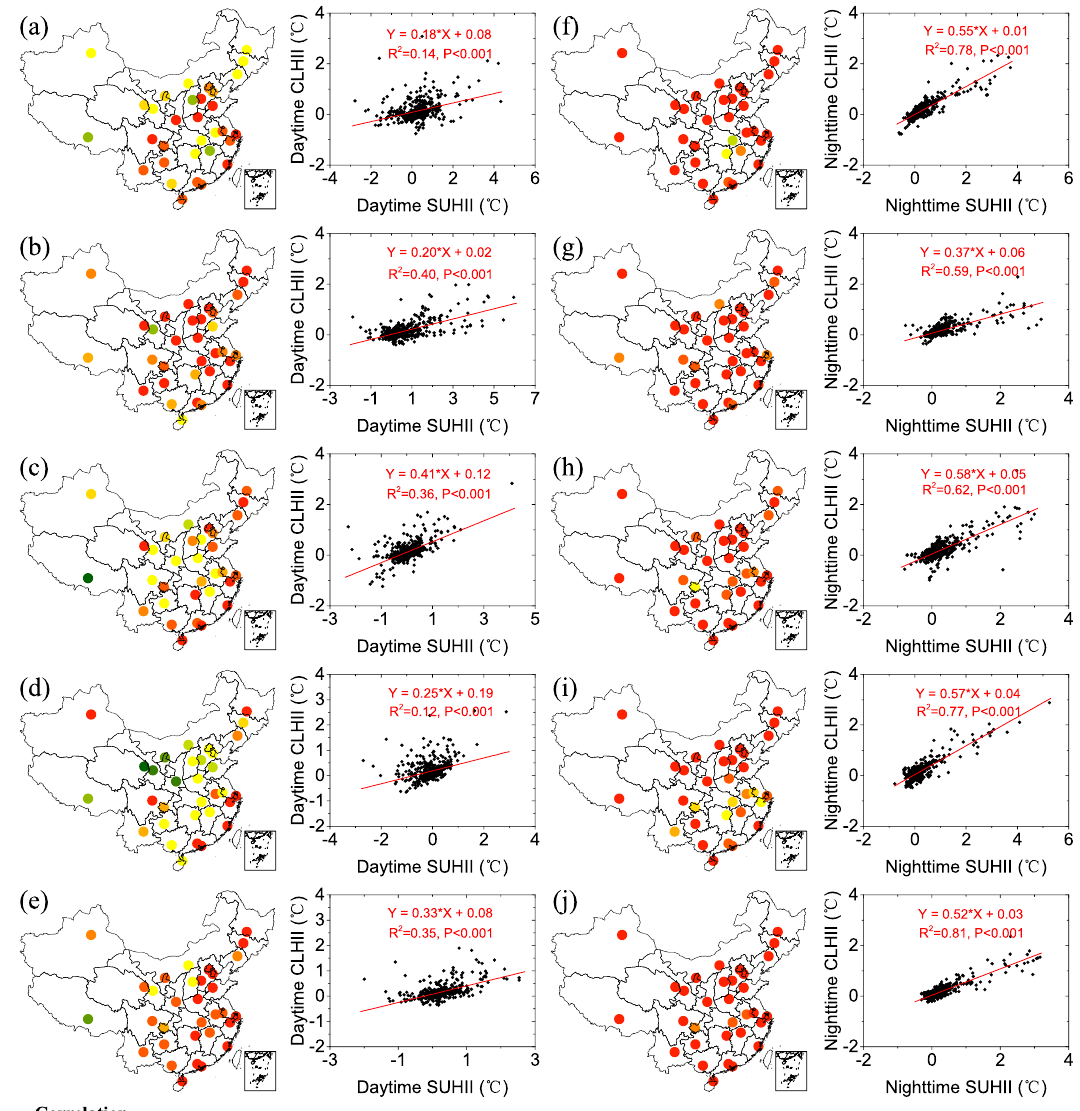
Figure 11. Relationships between CLHII and SUHII. Correlations and relationships between daytime (14:00) CLHII and daytime (~13:30) SUHII are shown in the vector and scatter diagram in ( a ) spring, ( b ) summer, ( c ) autumn, and ( d ) winter, respectively. ( e ) Shows the correlation of annual daytime CLHII with daytime SUHII. Correlations and relationships between nighttime (14:00) CLHII and nighttime (~01:30) SUHII are shown in the vector and scatter diagram in ( f ) spring, ( g ) summer, ( h ) autumn, and ( i ) winter, respectively. ( j ) Shows the correlation of annual nighttime CLHII with nighttime SUHII. The red line is the linear regression line.